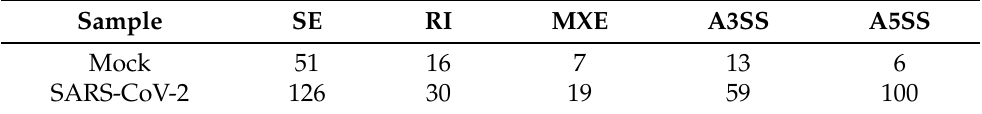
Table 1. Number of detected significant splicing events in each category between SARS-CoV-2 infected and mock-treated cells.